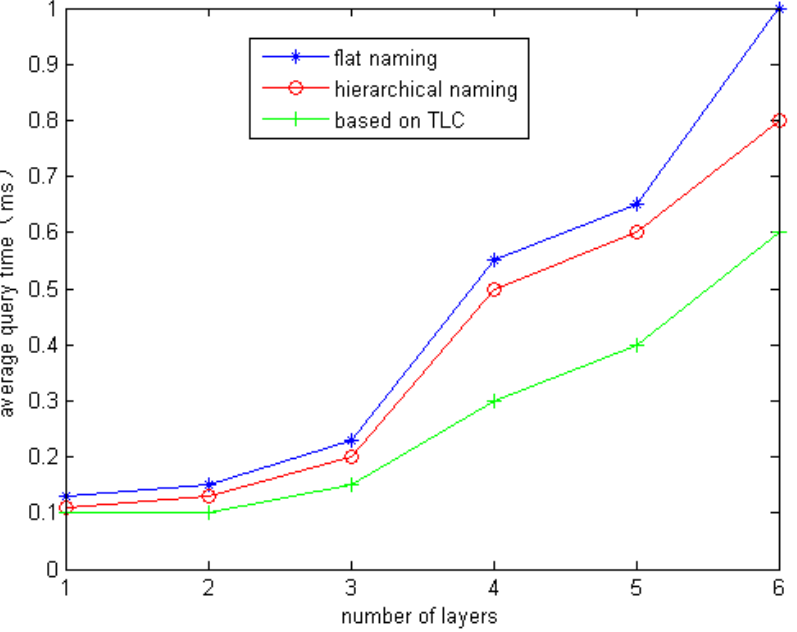
Figure 12. Comparison of the average query time under di ff erent numbers of layers.